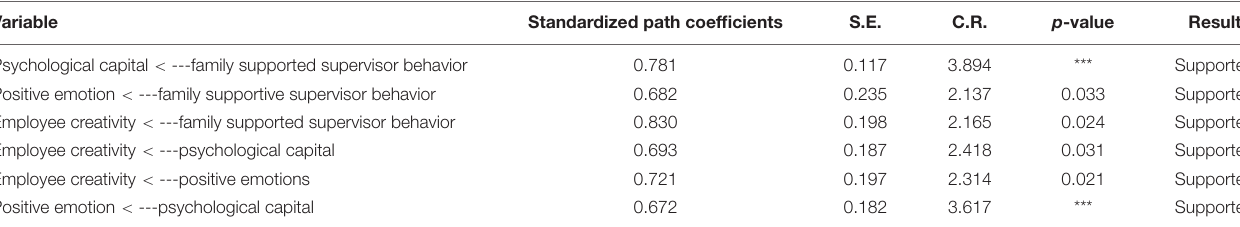
TABLE 5 | Model parameter